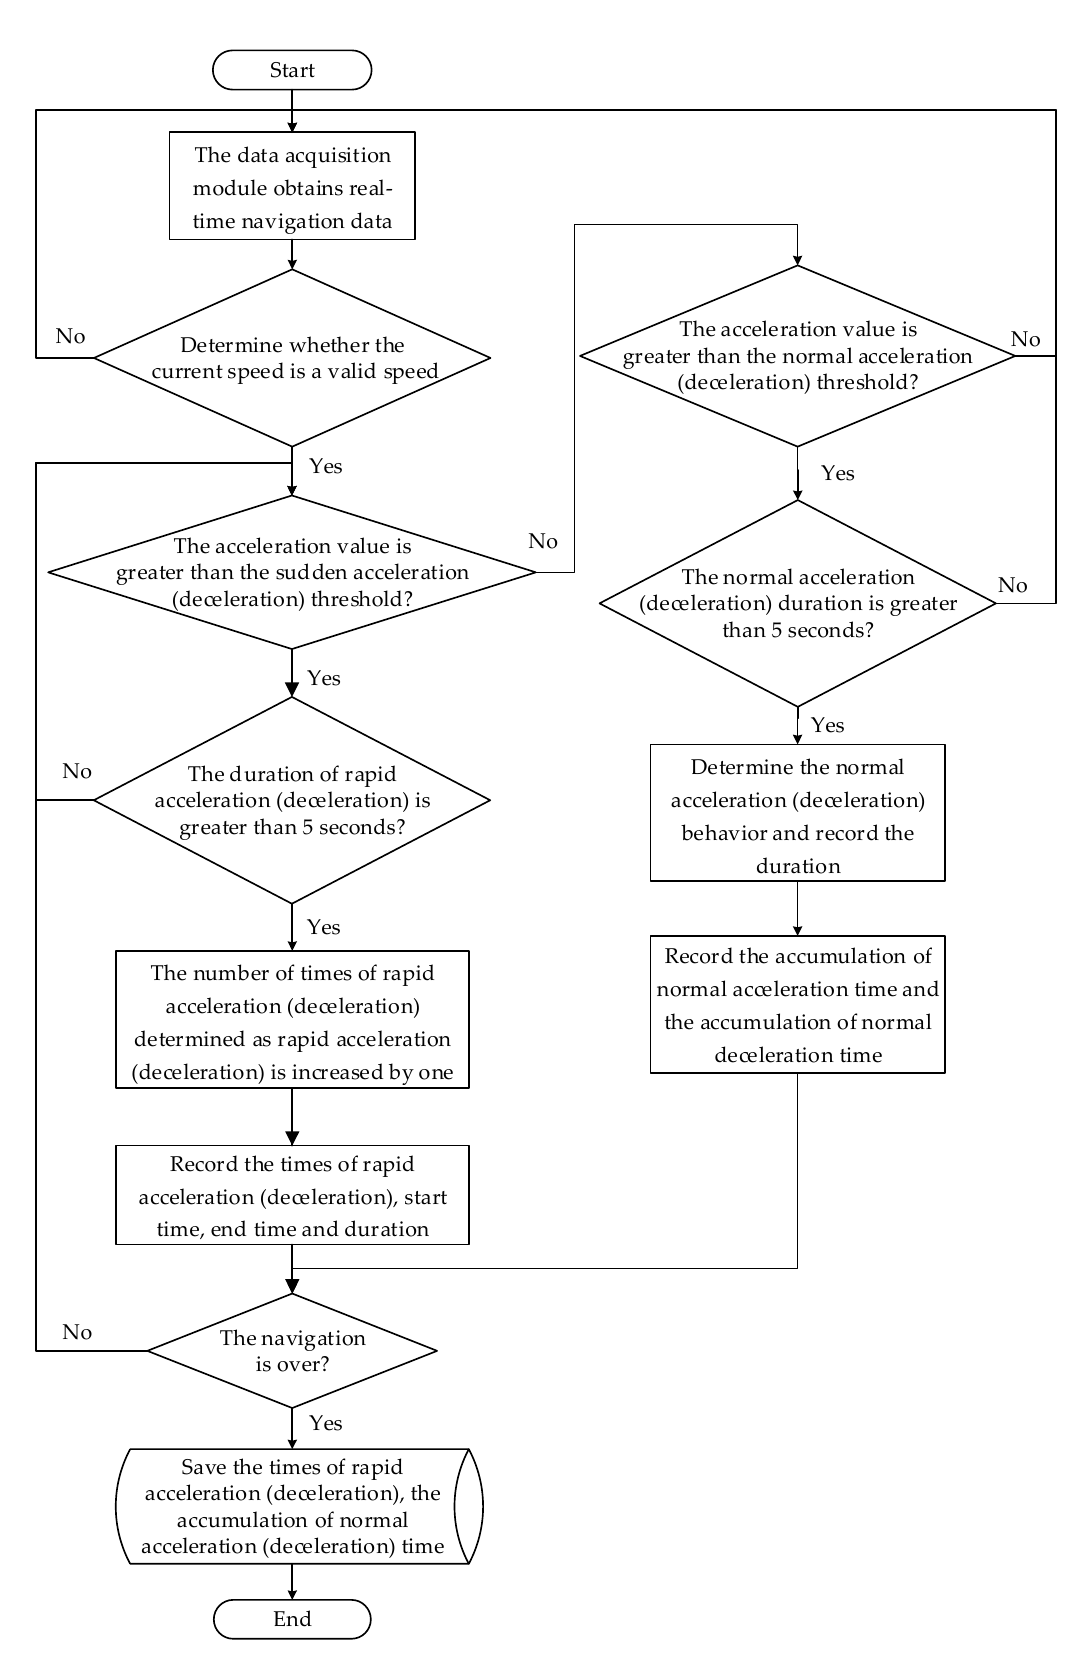
Figure 5. Flow chart of rapid acceleration times N acc , rapid deceleration N dec , normal acceleration time T acc and normal deceleration time T dec acquisition algorithm.